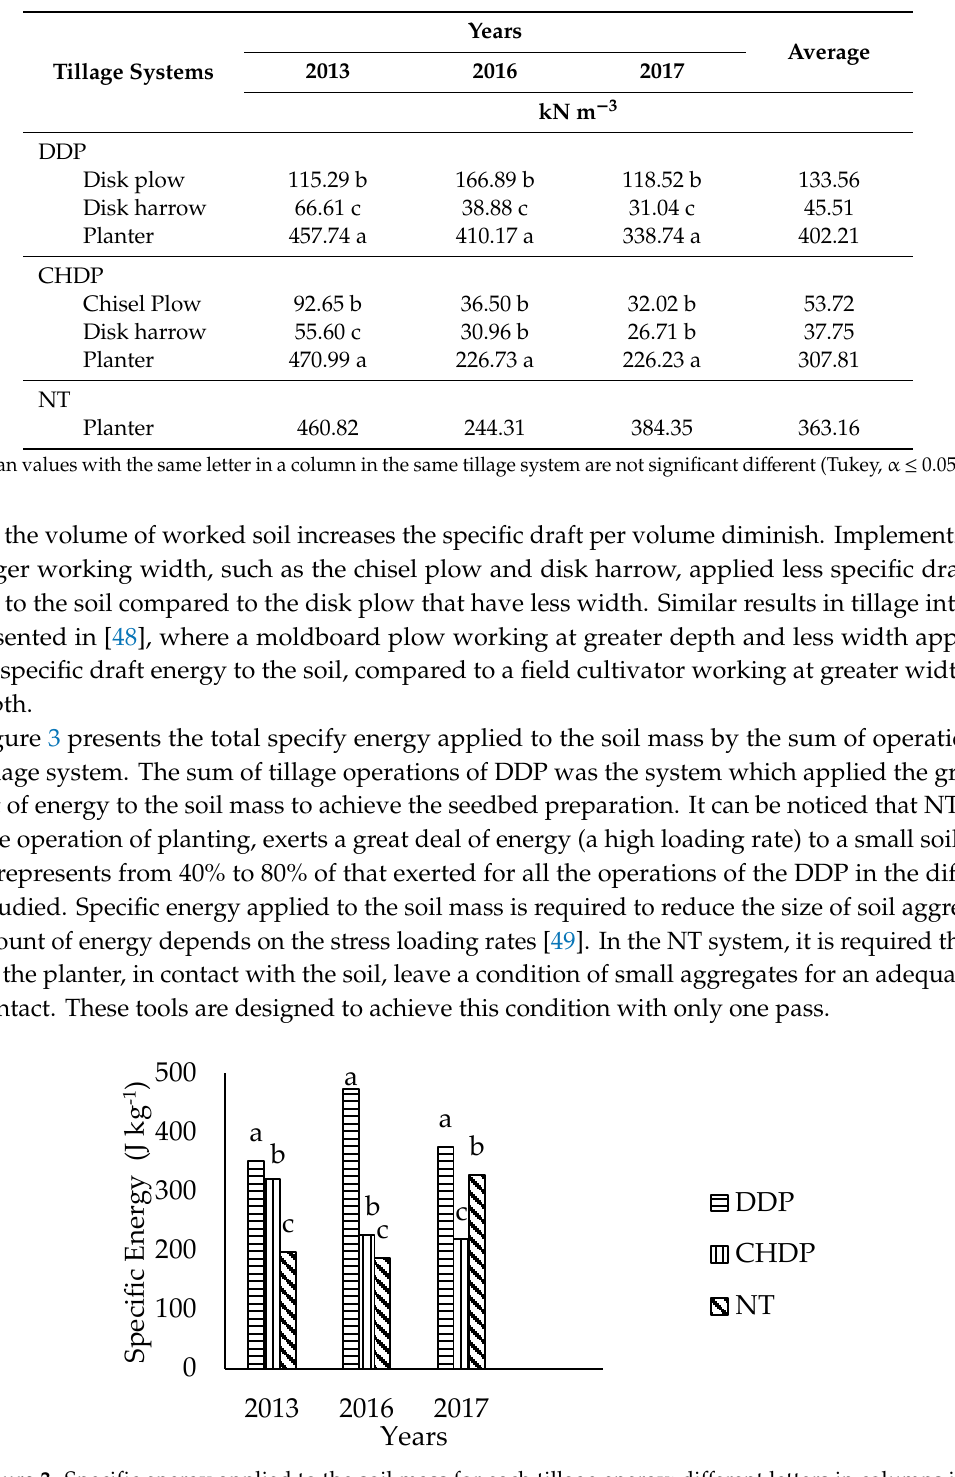
Table 8. Draft applied per volume of soil disturbed for each implement at each tillage system.